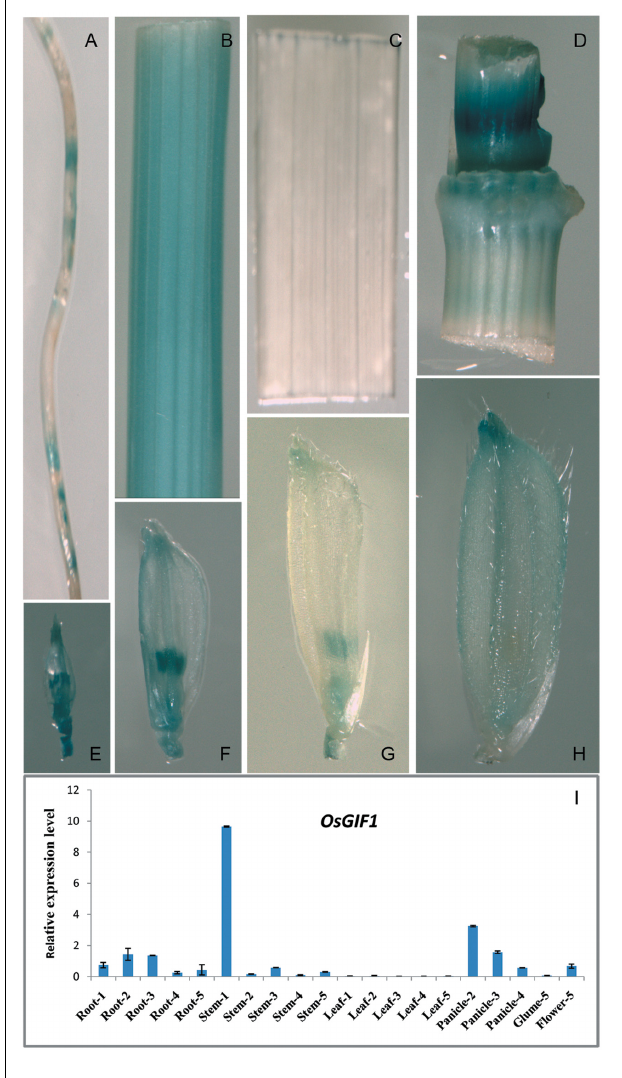
FIGURE 5 | Expression profile of OsGIF1. (A–H) GUS staining of various tissues of OsGIF1 pro:: GUS transgenic plants. (A) Root; (B) internode; (C) leaf; (D) stem node; (E–H) Spikelets of plants with panicle lengths of 2 (E) , 5 (F) , 10 (G) , and 15 cm (H) , respectively. (I) Relative expression levels of OsGIF1 in various tissues of WT plants. (1), (2), (3), (4), and (5) indicate plants with panicle lengths of 0, 2, 5, 10, and 15 cm, respectively. Values are all shown as mean ± SEM ( n = 3).